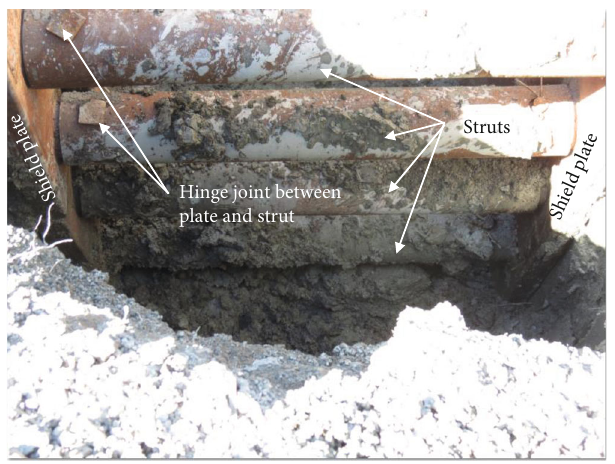
Figure 6: Experimental hinge joint between plate and strut of box shield. Table 2: Properties for Louiseville soil and Mohr-Coulomb material model parameters used for FE modelling.